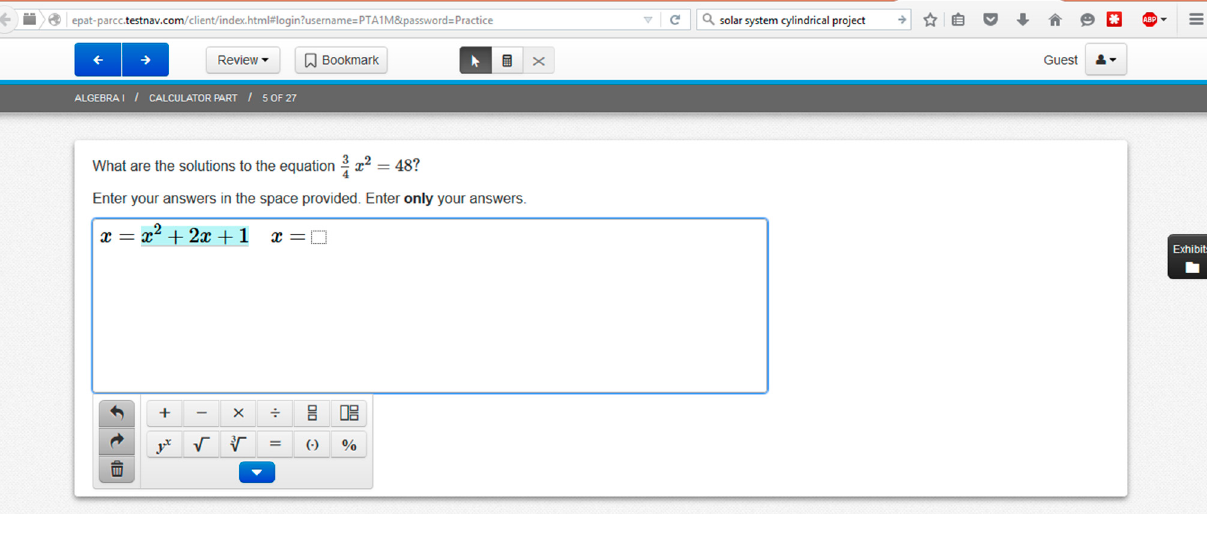
Figure 8. PARCC Equation Editor.